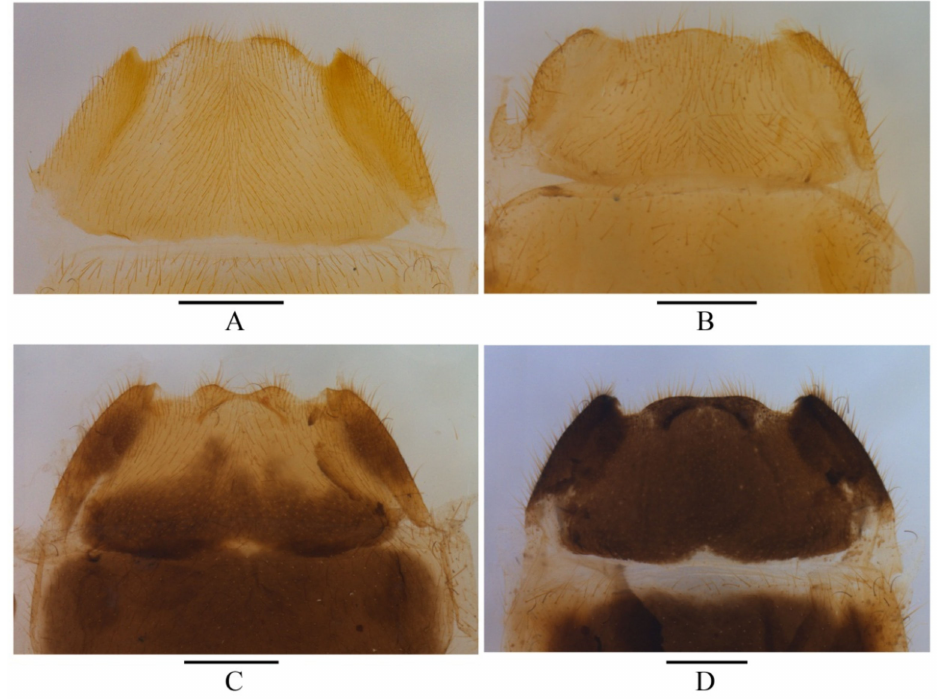
Figure 3. Abdominal sternite VIII of female, ventral view: ( A ) Lycocerus binotatus sp. nov. ; ( B ) L. testacicollis sp. nov. ; ( C ) L. daliensis sp. nov. ; ( D ) L. vietnamensis sp. nov. Scale bars: 0.5